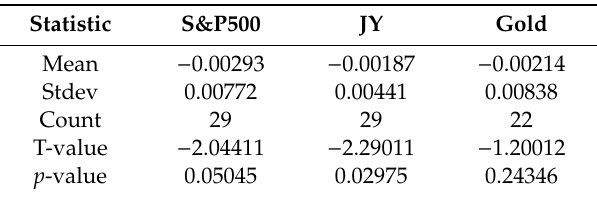
Table 9. The ($) h T ’s HE— the ($) h c ’s HE.